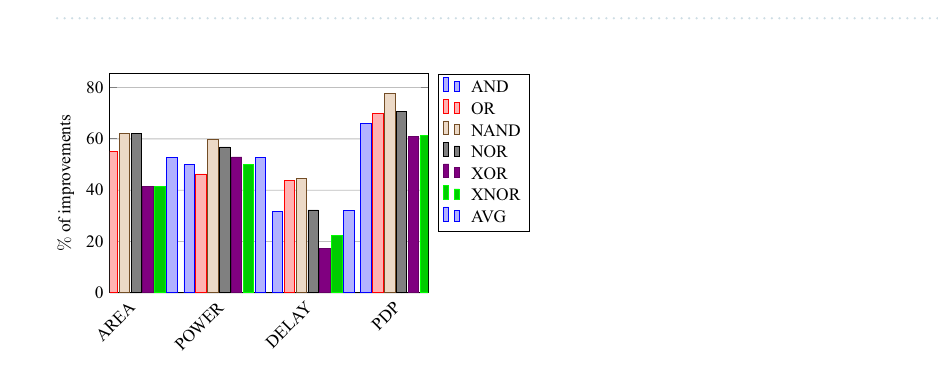
Figure 49. % of Overhead of keybased logic encrption over the proposed encryption.